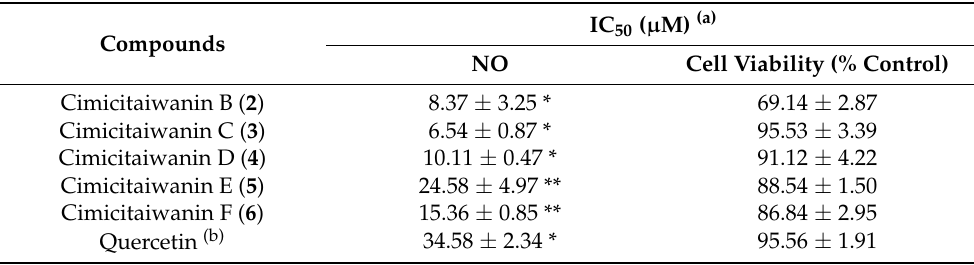
Table 4. Inhibitory effects of the 5 isolates ( 2 – 6 ) from Cimicifuga taiwanensis on LPS-activated NO production in RAW 264.7